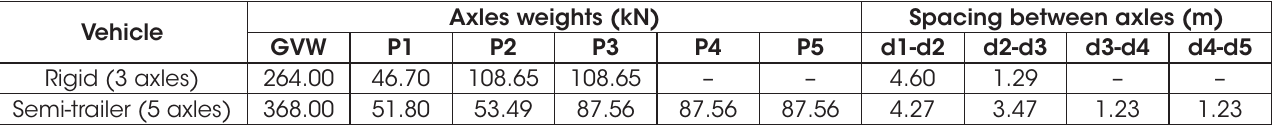
Axles weights (kN)